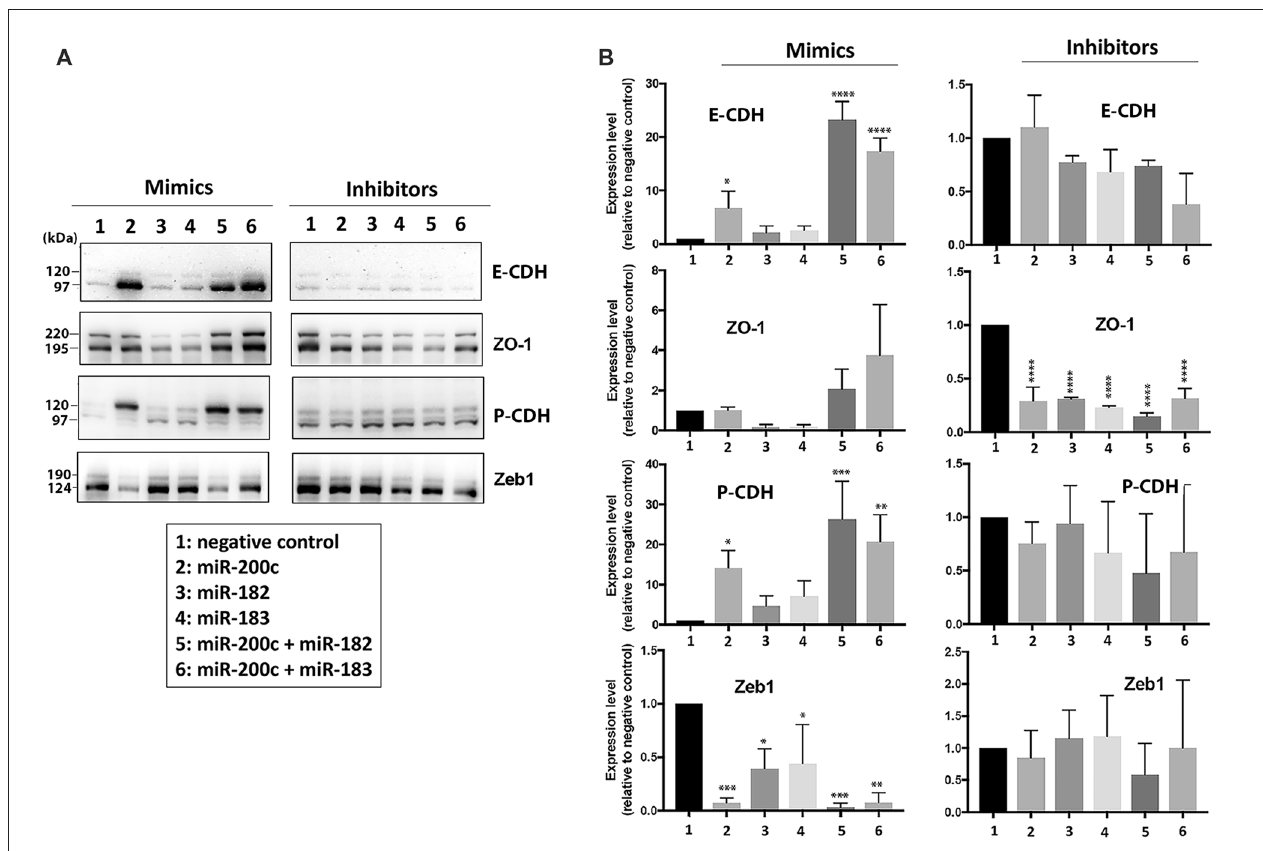
FIGURE 3 | Effect of overexpression or depletion of miRNAs on the expression of EMT-related proteins in SHSY5Y cells. (A) Representative immunoblots of EMT-related proteins. Left, overexpression by mimics; Right, depletion by inhibitors. (B) Quantitative analyses of EMT-related protein expressions. Left, overexpression of miRNA by mimics, Right, depletion of miRNA by inhibitors. 1, negative control; 2, miR-200c; 3, miR-182; 4, miR-183; 5, miR-200c + miR-182; 6, miR-200c + miR-183. Data represent the mean ± SD of at least three independent experiments. The statistical analyses were shown relative to the negative